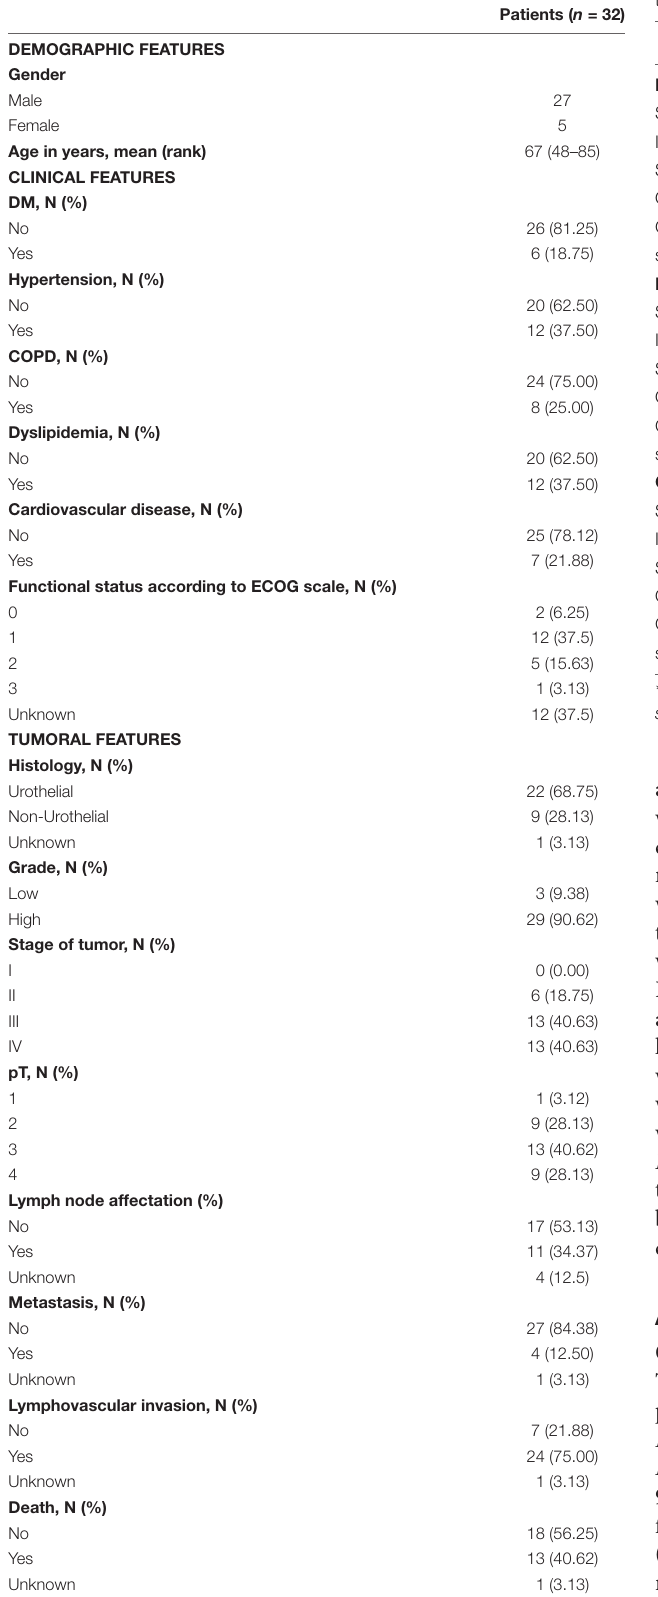
TABLE 1 | Clinicopathological features of the patients included in this study. TABLE 2 | Comparison of α -diversity indices between tumor and matched normal